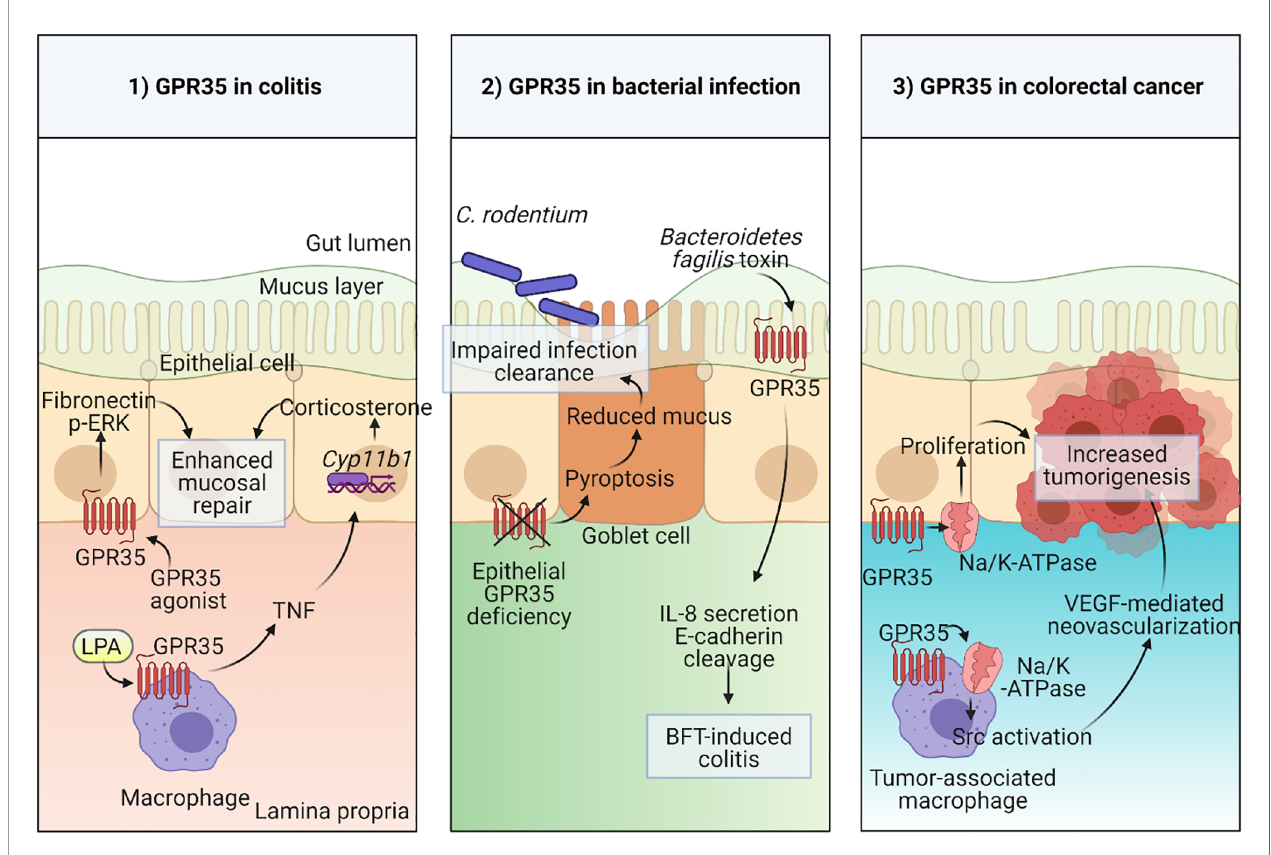
FIGURE 1 | Physiological functions of GPR35 in the intestine 1) Macrophage expressed GPR35 induces TNF accompanied by transcription of Cyp11b1 encoding for steroidogenic enzyme 11 b – hydroxylase in epithelial cells during colitis. In a second mechanism, epithelial GPR35 promotes mucosal repair through ERK and fi bronectin-mediated proliferation. 2) Disruption of GPR35 signaling in epithelial cells leads to pyroptosis in goblet cells resulting in reduced mucus production and therefore an impaired mucosal barrier integrity which leads to increased susceptibility to C. rodentium infection. GPR35 serves as a sensor in Bacteroidetes fragilis toxin (BFT)-induced colitis. 3) GPR35 interaction with Na/K-ATPase pump induces Src activation in both epithelial cells and tumor-associated macrophages (TAMs) in colorectal cancer model via increased proliferation in epithelial cells and neovascularization in response to TAM-derived VEGF. Created with